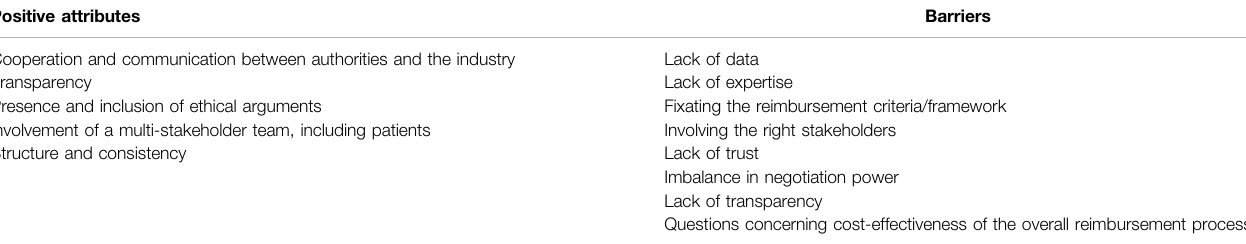
TABLE 2 | Positive attributes and barriers perceived by experts, concerning reimbursement processes for orphan drugs. Positive